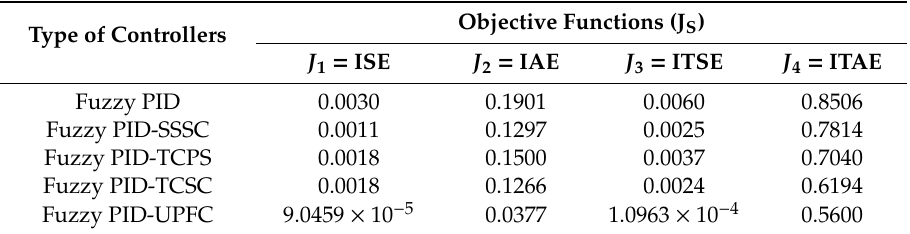
Table 3. Function values. ITAE—integral of time-weighted absolute error (ITAE); ISE—integral of squared error; ITSE—integral of time-weighted squared error; IAE—integral of absolute error.